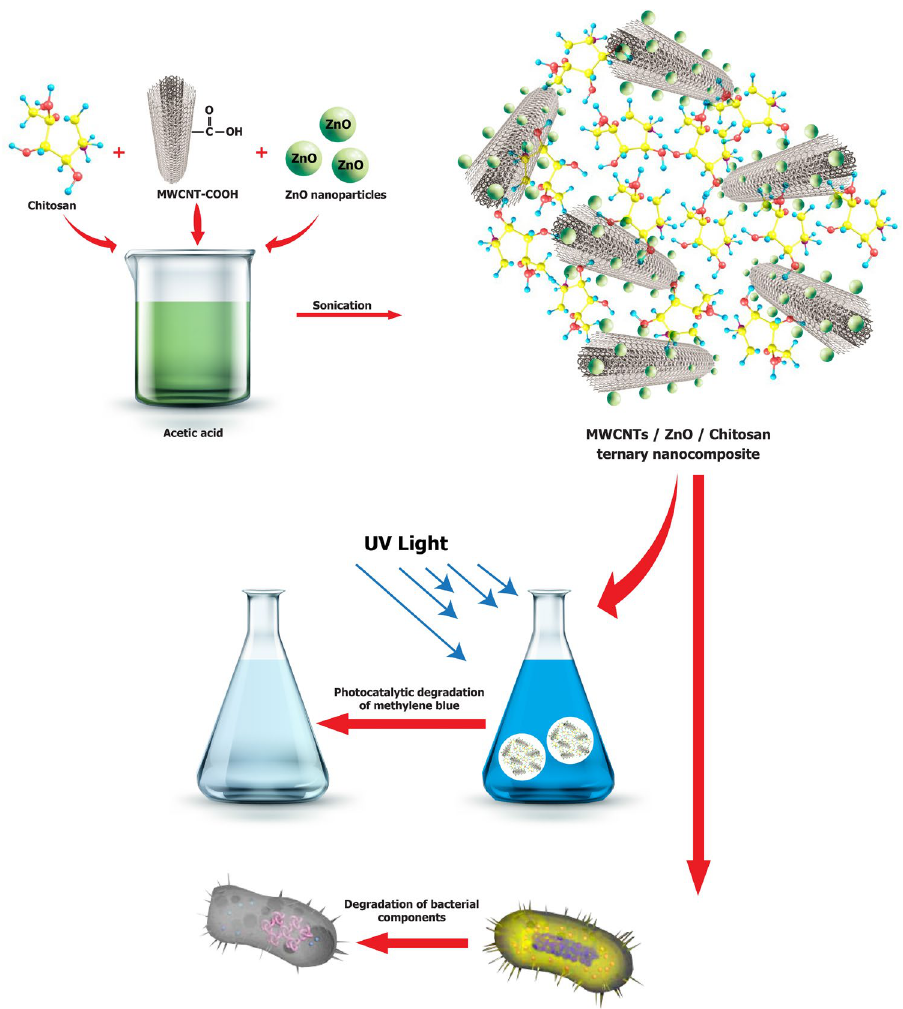
Figure 1. Schematic illustration of the synthesis and photocatalytic activity of MWCNTs/ZnO/Chitosan ternary